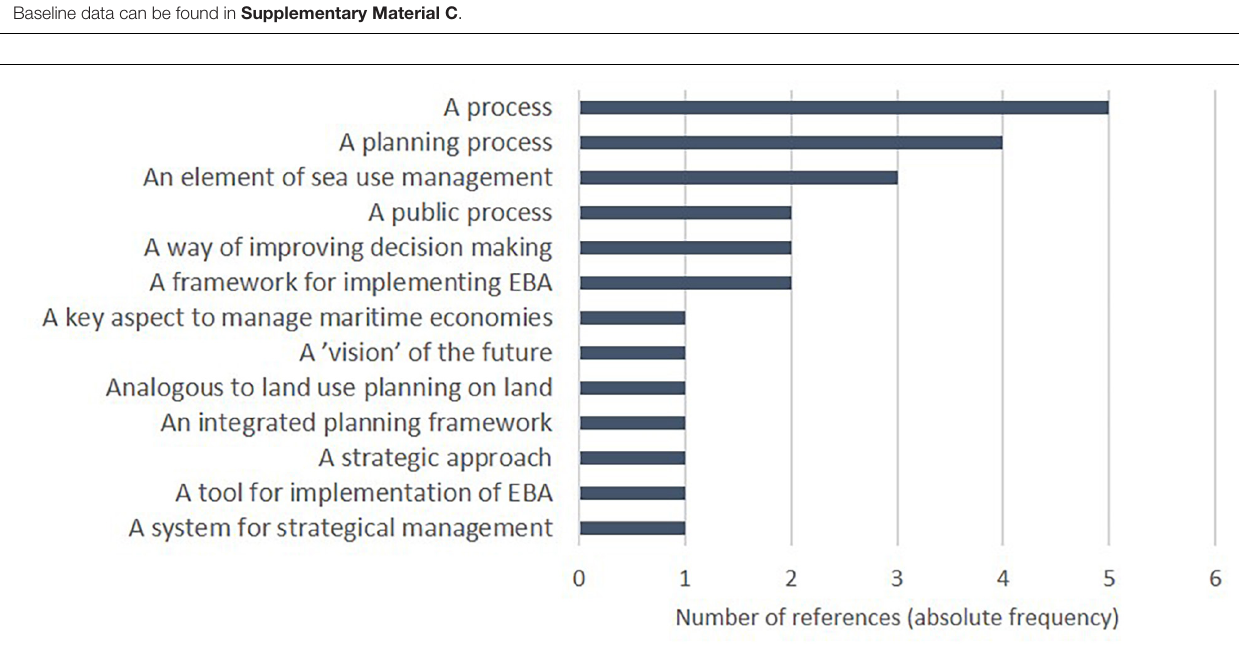
FIGURE 3 | Main definitions of what MSP is, found in the 30 “defining” documents. Five out of the 30 documents only defined what MSP does and not what MSP is. For that reason, they are not reflected into the graphic. Baseline data in Supplementary Material B .